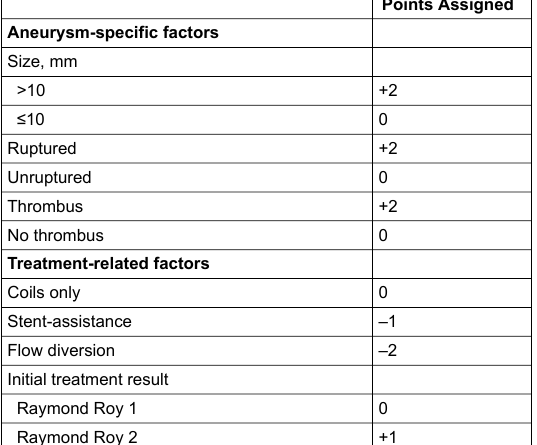
Points Assigned